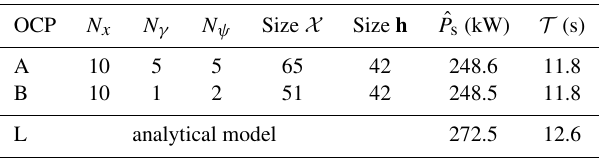
Figure 15. First Fourier coefficient of elevation β and azimuth φ (x) found by solving multiple OCPs and analytical expression (–) as a function of the modified non-dimensional mass parameter M t . Table 3. Settings of the two optimal control problems maximizing the mean shaft power considering gravity.